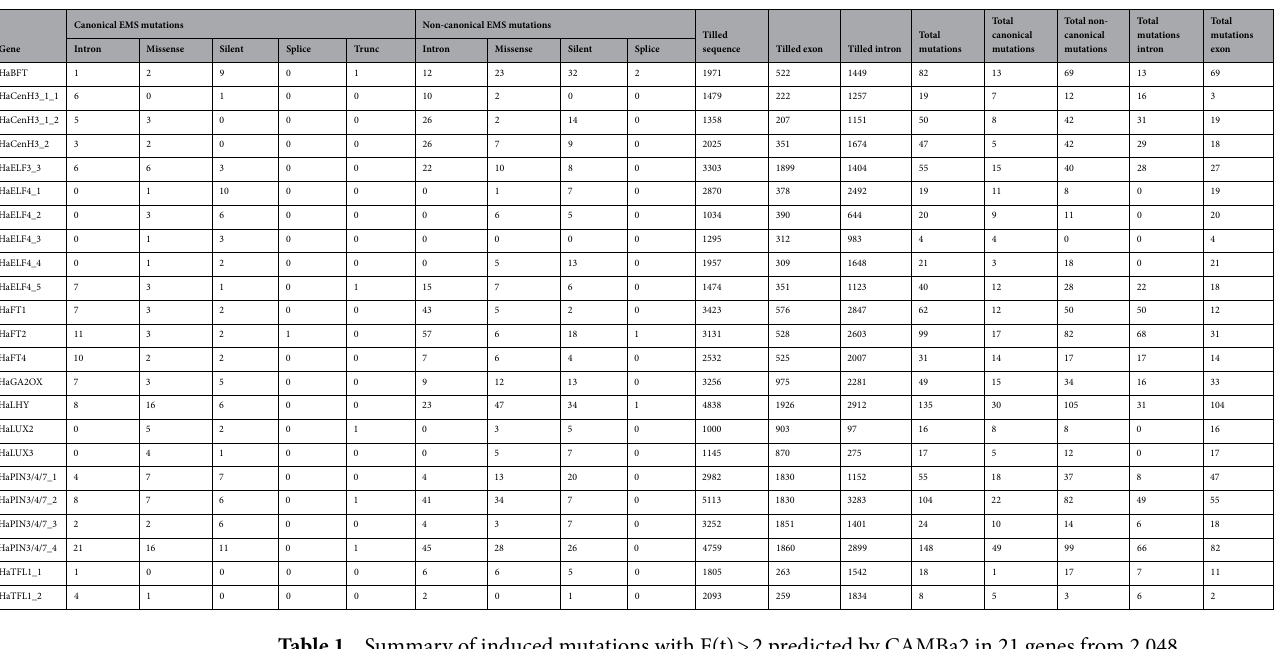
Table 1. Summary of induced mutations with F(t) > 2 predicted by CAMBa2 in 21 genes from 2,048 individuals of the M 2 sunflower population.